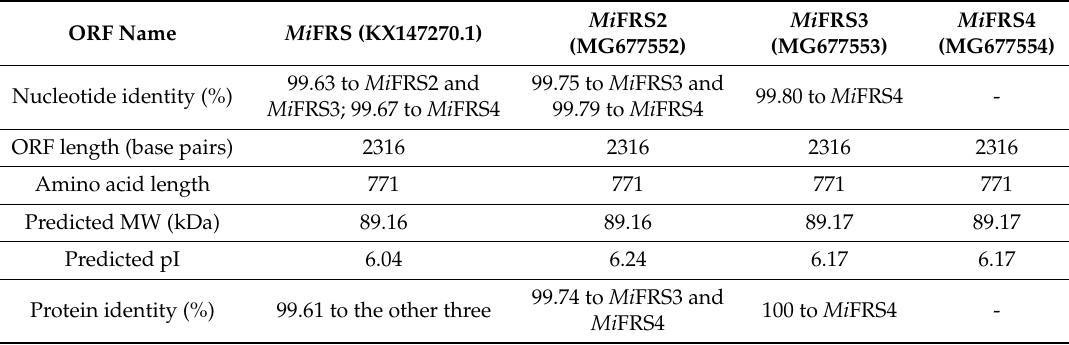
Table 1. Identity and features among the four cds and ORFs of Mi